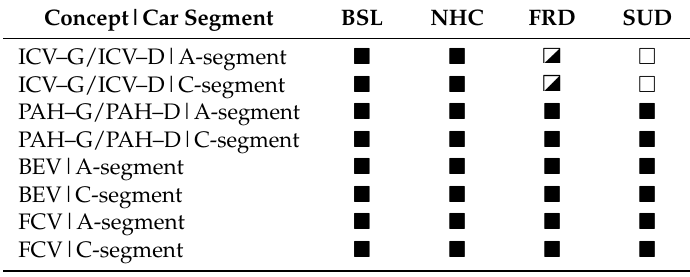
Table 11. Matrix of fuel economy assessments of passenger car concepts considered. Definition of BSL (“Baseload only”), NHC (“No heating and cooling”), FRD (“Frost day”) and SUD (“Summer day”) cases see Table 10; ICV: internal combustion engine vehicle; PAH: Parallel hybrid; BEV: Battery electric vehicle; FCV: Fuel cell electric vehicle; G: Gasoline; D: Diesel; For a specification of car segments, see Table 4. Concept|Car